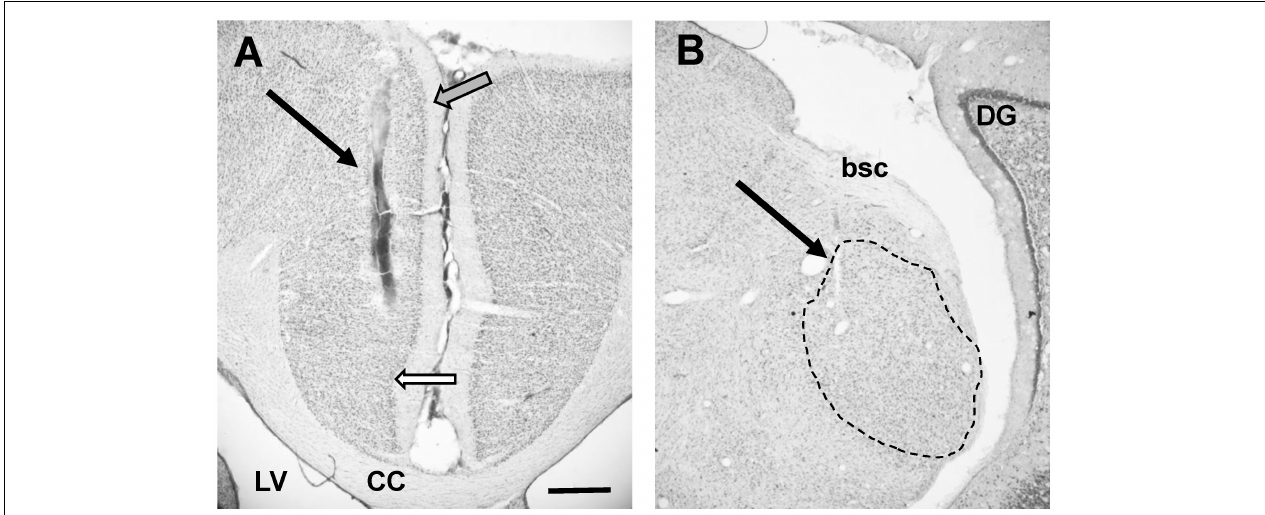
FIGURE 2 | (A) Photomicrograph showing placement of stimulating electrode in PFC (arrow). Note that this image does not show deepest point of electrode. White filled arrow points to tentative border infralimbic and cingulate cortex. Grey filled arrow points at tentative border between cingulate cortex and secondary motor cortex. Please note that delineations of the cortex are based on rat atlases (Paxinos and Watson, 2007; Swanson, 2018) since the guinea pig atlas (Rapisarda and Bacchelli, 1977) does not show detailed delineations. (B) Photomicrograph showing placement of recording electrode in MGN (arrow). Dotted line shows outline of MGN, based on rat atlas (Swanson, 2018). Individual subdivisions of the MGN not indicated. CC, corpus callosum; LV, lateral ventricle; DG, dentate gyrus; bsc, brachium of the superior colliculus. Scale bar for both images: 0.5 mm.